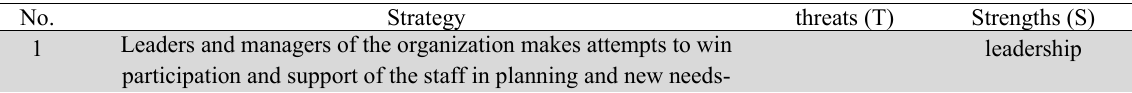
Human resource ST strategies No. Strategy threats (T) Strengths (S) 1 Leaders and managers of the organization makes attempts to win participation and support of the staff in planning and new needs-